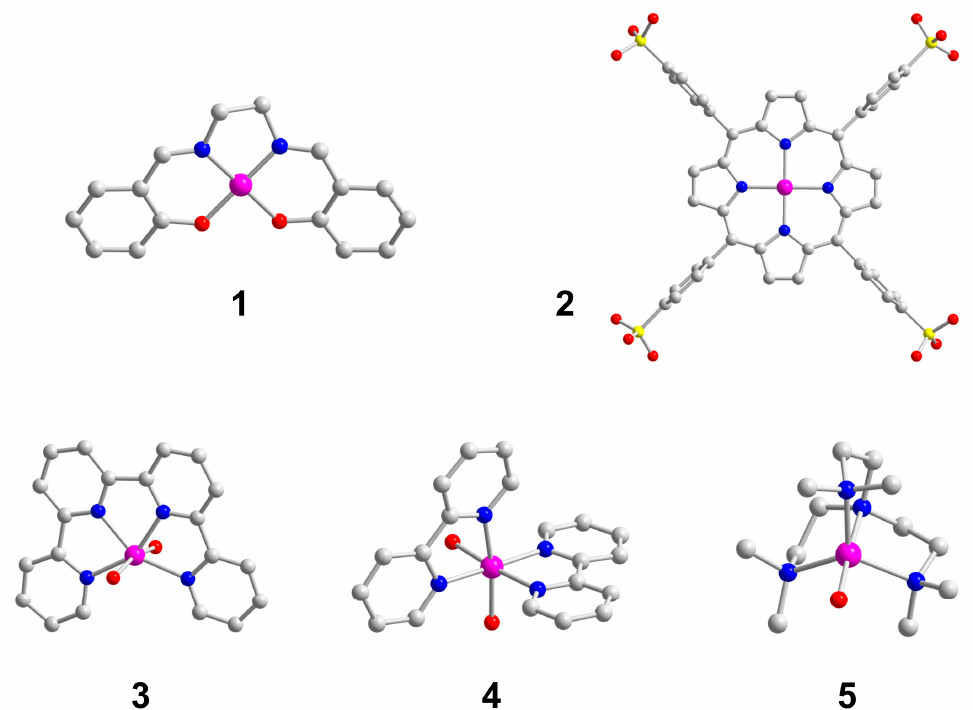
Figure 2. Structures of complexes 1 – 5 . Color scheme: Co, pink; O, red; N, blue; S, yellow; C, grey.